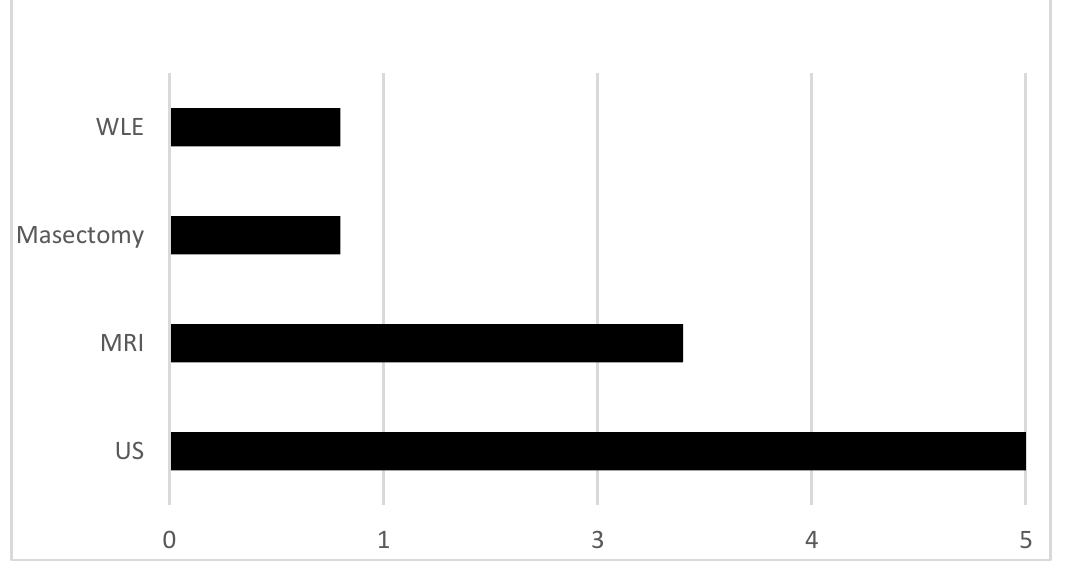
Figure 1. Methods used to sample tissue from magnetic resonance imaging (MRI)-indeterminate lesions. Out of the 10 MRI indeterminate lesions, eight were biopsy-proven malignant (ductal carcinoma in situ (n = 4), invasive ductal carcinoma (n = 1) and invasive lobular carcinoma (n = 3)). The remaining lesions were benign fibroadenomas (n = 2) (see Figure 2 and Table 2).